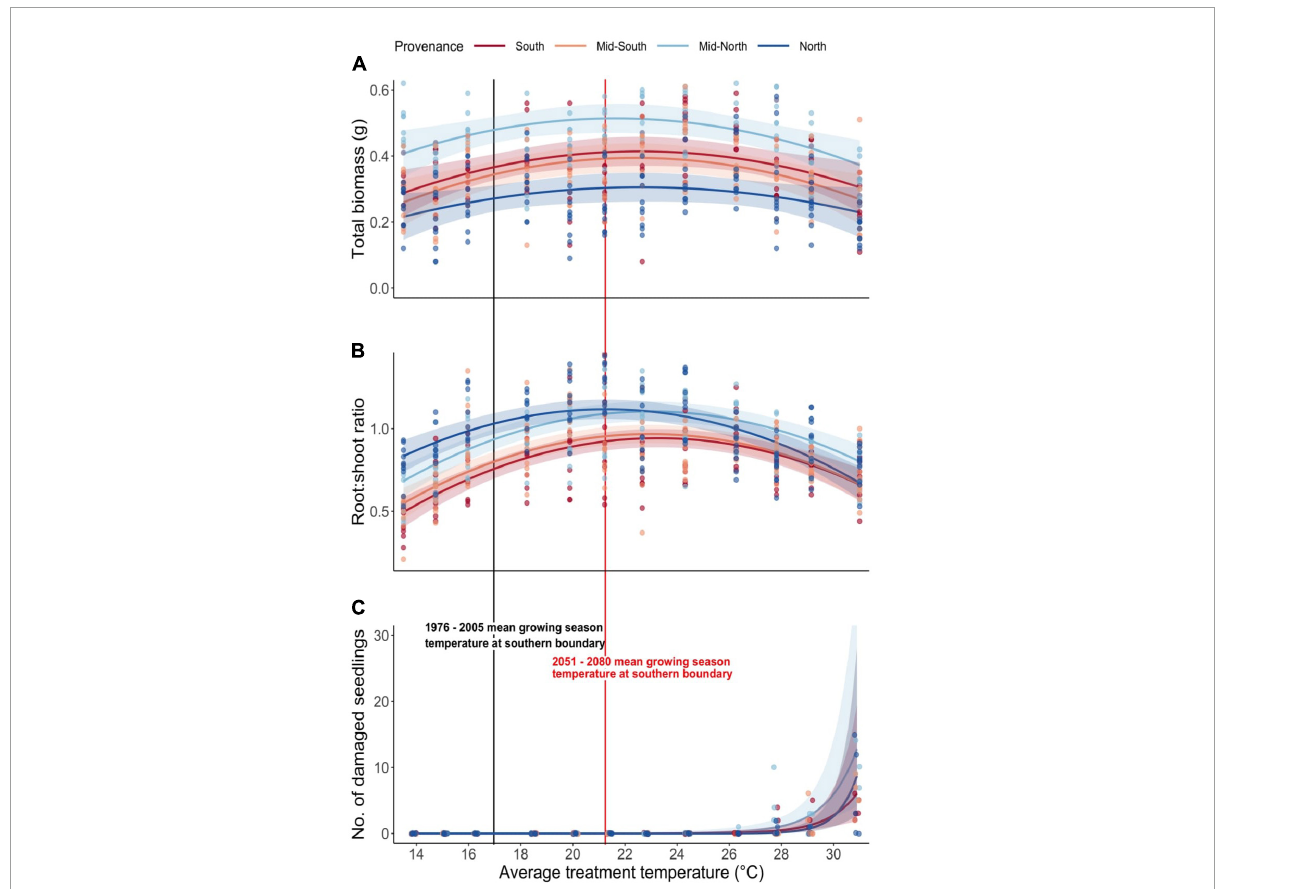
FIGURE2 Interaction plots (Long, 2019) depicting the relationship between average treatment temperature and (A) the total seedling biomass (g), (B) seedling root:shoot ratio (RSR), and (C) the number of seedlings with severe needle damage. Colored bands represent 95% confidence intervals. The black vertical line shows the mean average daily temperature (17 ◦ C; May—September ) within the hottest part of balsam firs range in the recent past. The red vertical line shows the RCP 8.5 projected average daily temperature (21.3 ◦ C; May—September ) within the same region by 2051–2080 (Pacific Climate Impacts Consortium,